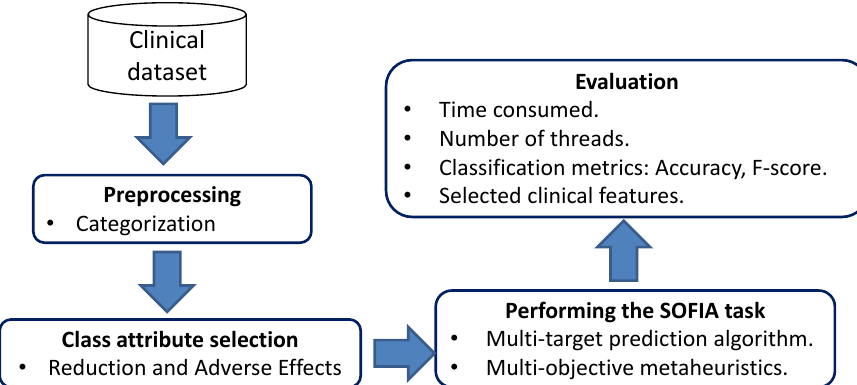
Figure 3. SOFIA experiment